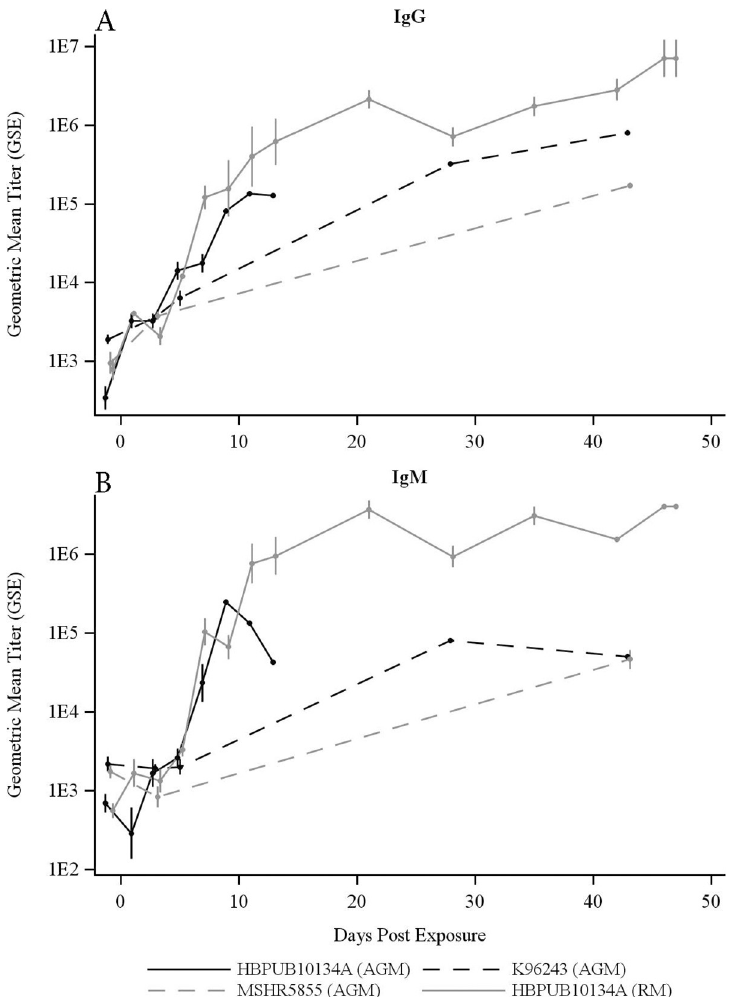
(GSD) IgG and IgM titers of 20,950(2.67) and 4,314 (2.18), respectively. The 5 AGM exposed to K96243 and euthanized on days 4 to 43 had terminal IgG and IgM titers of 33,355 (12.38) and 7,651 (7.01), respectively, and the 5 AGM exposed to MSHR5855 and euthanized on days 8 to 43 had IgG and IgM titers of 172,355 (1.14) and 46,661 (1.62). By contrast, the 5 RM euthanized from day 13 to 47 had terminal IgG and IgM titers of 4,940,009 (2.60) and 3,964,462 (1.05), respectively. The AGM groups were each significantly different from RMs exposed to HBPUB10134a, for both IgG and IgM, by t -test (p <